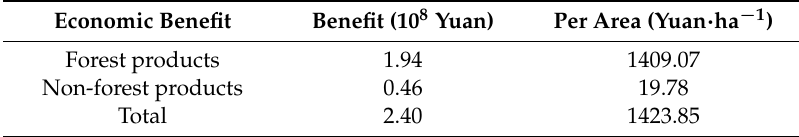
Table 2. Economic income of public welfare forest in Yanqing District in